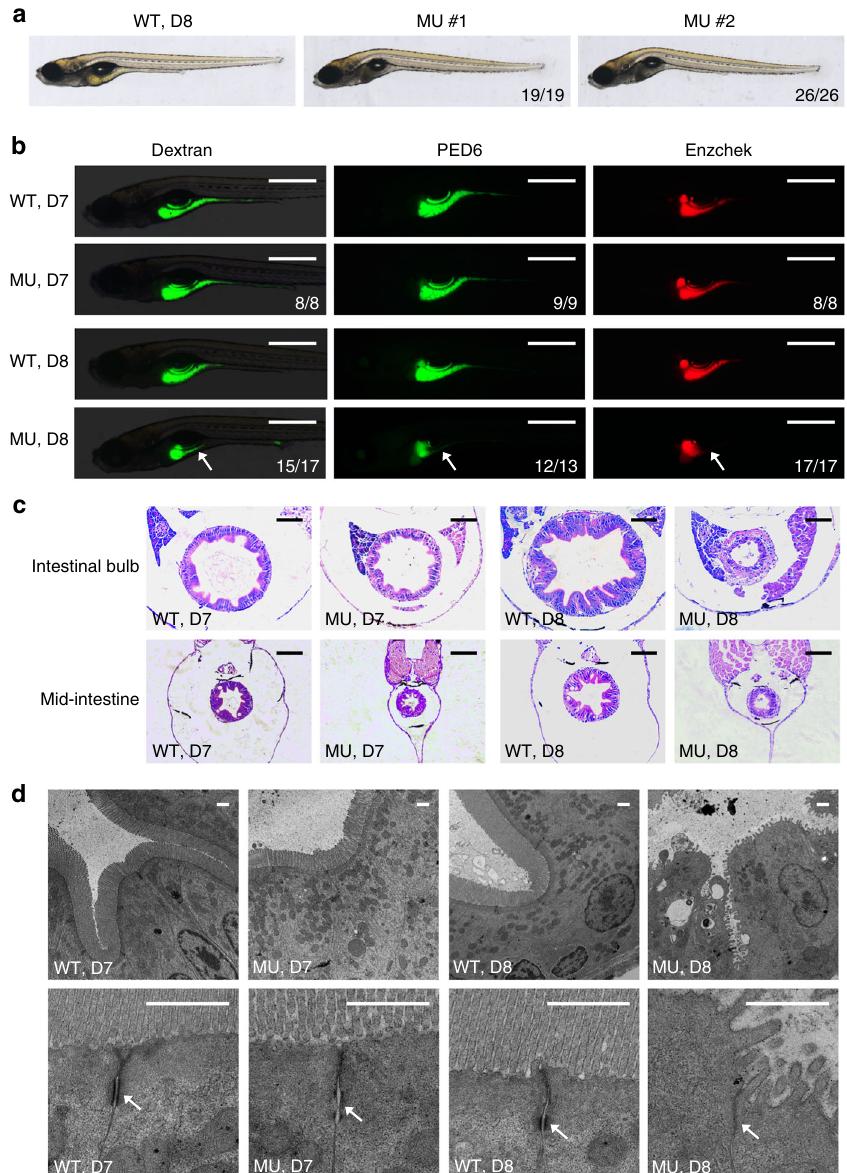
Fig. 1 Intestinal defects in pik3c3 mutants. a General morphology of WT and pik3c3 mutants at 8 dpf. b In vivo imaging of zebra fi sh digestive organ with fl uorescent reporters. FITC-labeled dextran is used to evaluate the nutrient uptake activity and the quenched fl uorescent reporter PED6 or Enzchek is activated only after cleavage by intestinal phospholipase or protease. The digestive functions appear normal in mutants at 7 dpf while they become defective at 8 dpf. Scale bars, 500 µ m. Numbers in ( a , b ) represent (embryos with the indicated phenotype)/(total embryos analyzed). c Hematoxylin – eosin staining of cross sections corresponding to the intestinal bulb or mid-intestine of embryos at 7 – 8 dpf. Typical intestinal folding is lost and cell shedding can be detected in pik3c3 mutants at 8 dpf. Scale bars, 50 µ m. d TEM analyses of IECs. Adherens junctions (arrow) are defective in mutants. Microvilli and cell junctions are severely disrupted in mutants at 8 dpf. Scale bars, 1 µ